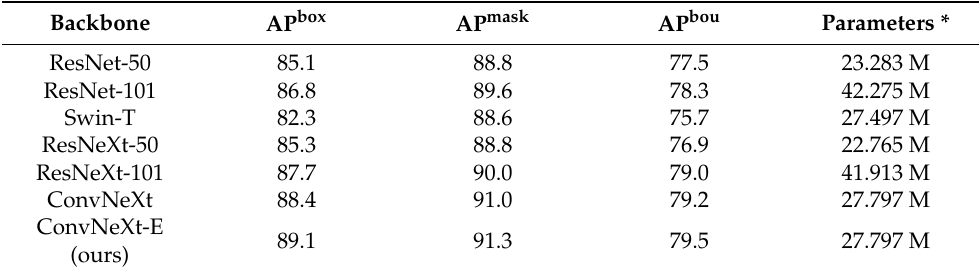
Table 3. SheepInst with different backbones on test set.